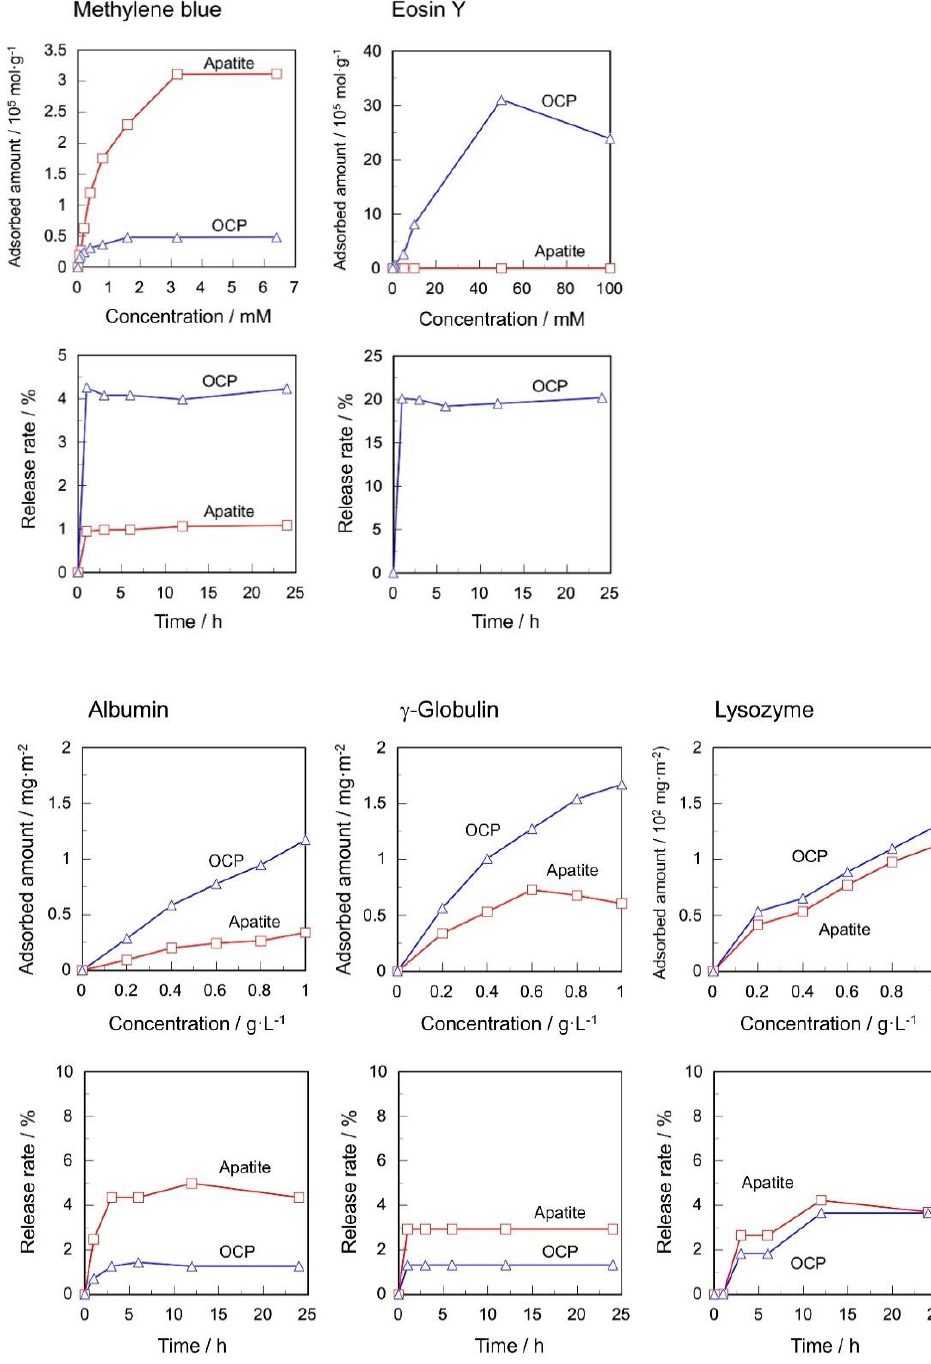
Figure 7. Adsorption and release profiles of various dyes and proteins incorporated into apatite and OCP microspheres by post treatment. The release rate of eosin Y from the apatite was not measured because the adsorbed amount was too small.